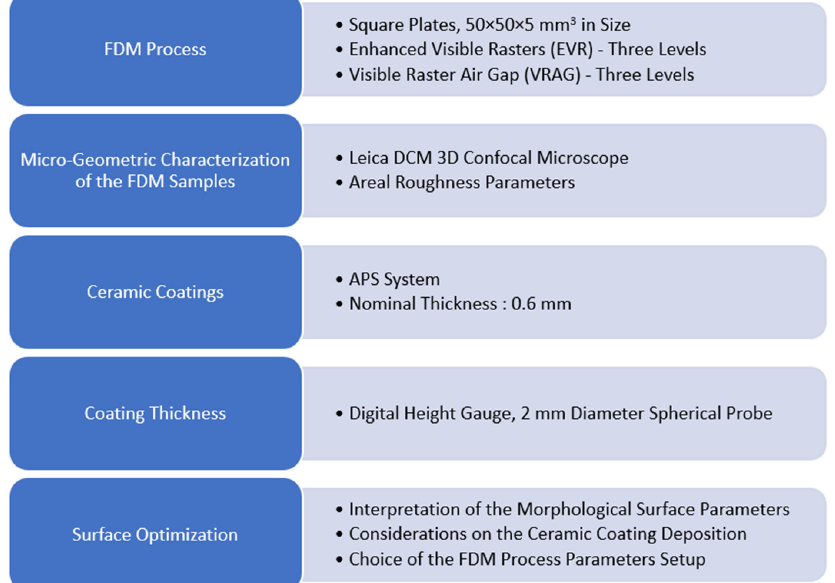
Figure 4. Flowchart of the research framework.